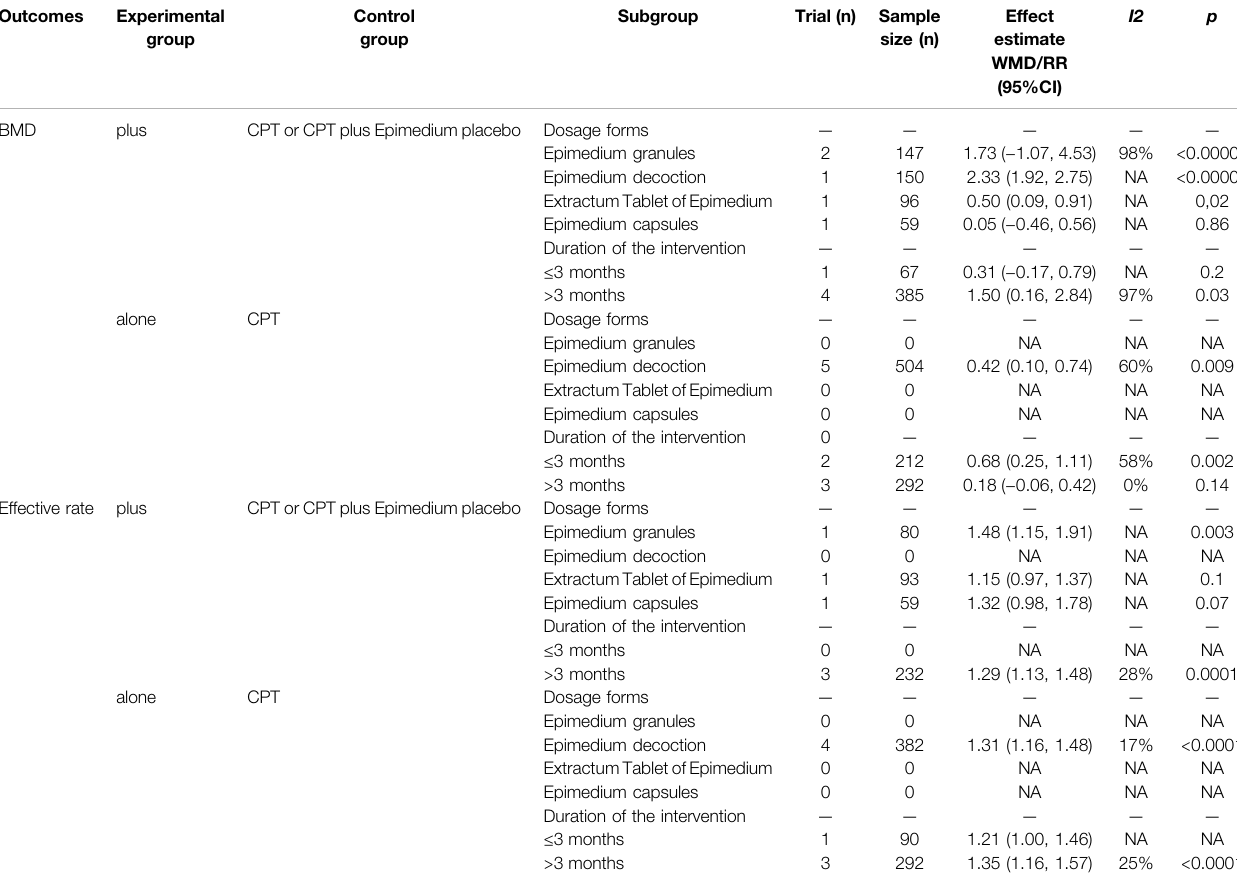
TABLE 6 | Summarized results of subgroup analyses. Outcomes Experimental